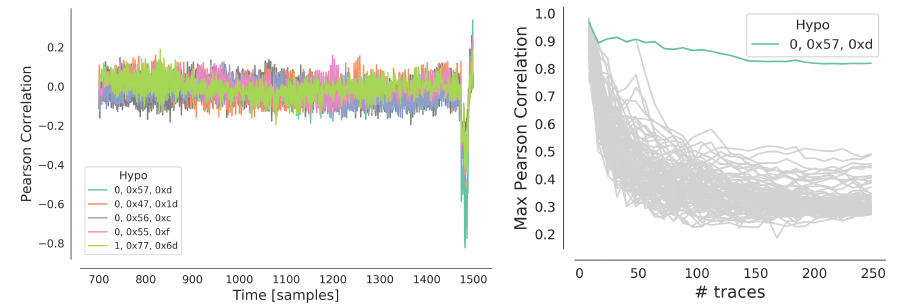
Figure 19: Pearson Correlation coefficients in Step 1, with 256 traces as a function of the time samples (left) and their maximum as a function of the number of traces (right).